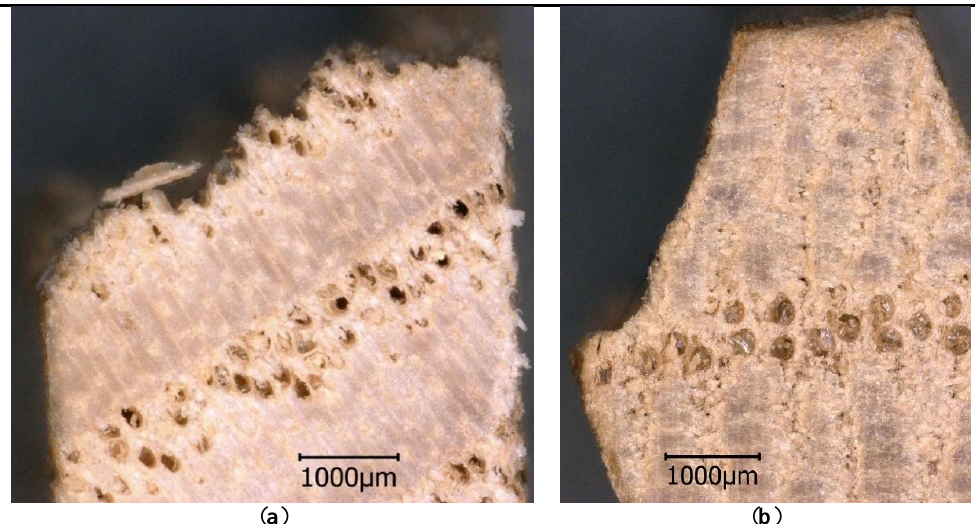
Figure 3. The fracture pattern in the ring-porous hardwoods: ( a ) Cross section of the Ash, fracture within a ring of the earlywood vessels; ( b ) Cross section of the English oak heartwood, fracture along the field of the latewood pores and the adjacent parenchyma cells.